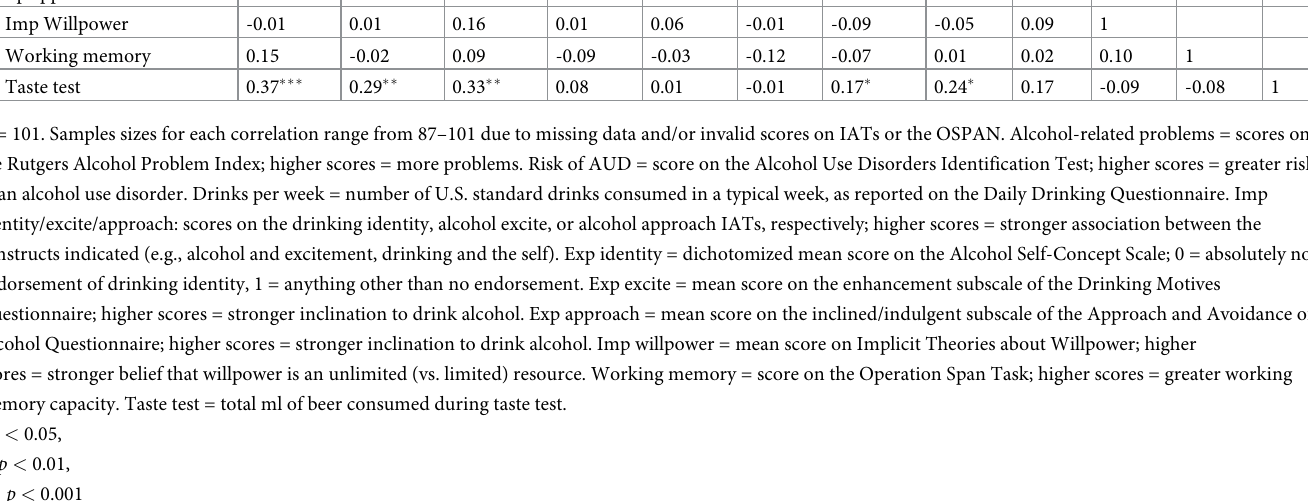
Table 3. Manipulation check.